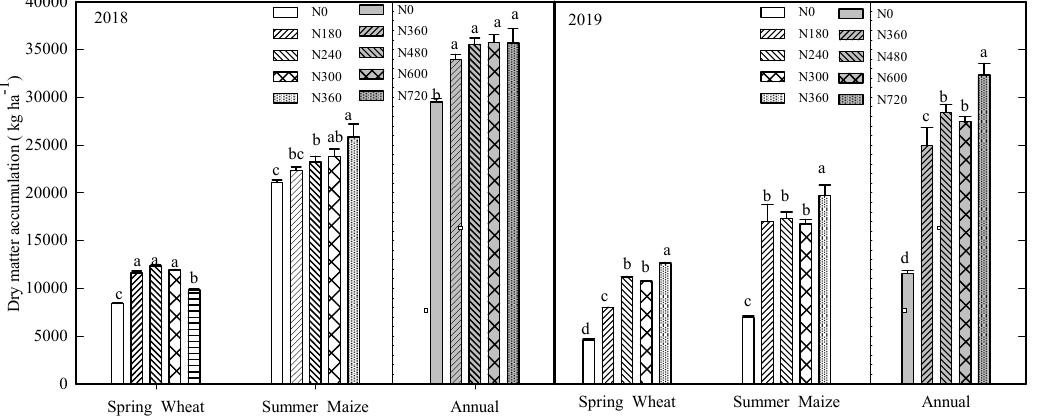
Figure 3. Spring wheat, summer maize and annual cereal dry matter accumulation responses to different nitrogen application rates. Note: The lowercase letters above bar graph indicate the significant differences at p < 0.05 levels.